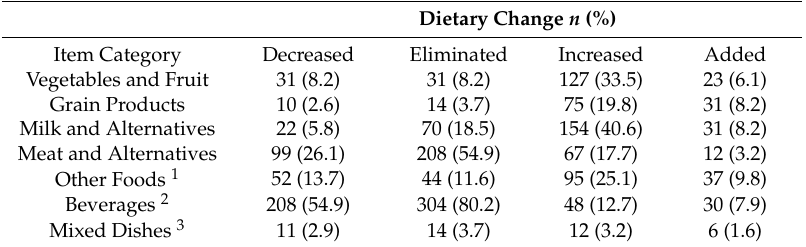
Table 3. Proportion of women who reported dietary changes during their pregnancy.